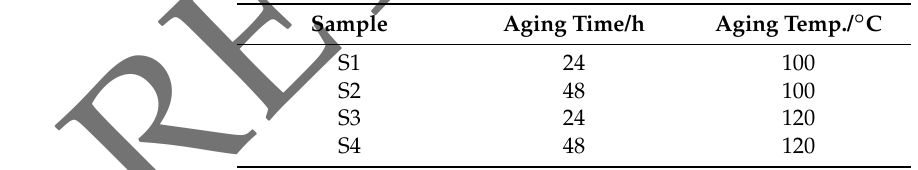
Table 3. The parameters of catalyst preparation.